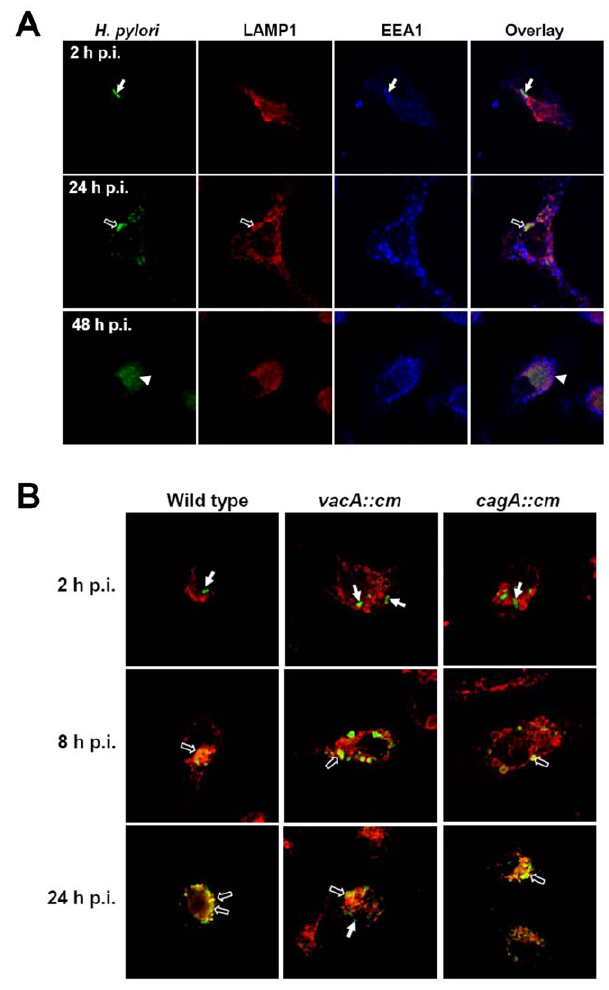
Figure 3. H.pylori in LAMP1 + vesicles within BMDCs. (A) The endocytic trafficking of H. pylori within BMDCs. BMDCs were infected with HP238 at m.o.i.=10. At 2, 24, or 48 h post infection, the infected cells were stained with anti- H. pylori antibodies (green), anti-EEA1 antibody (blue), or anti-LAMP1 antibodies (red). Confocal images show the localization of H. pylori with EEA-1 + or LAMP-1 + vesicles. Closed arrows indicate EEA-1 + H. pylori -containing vesicles, opened arrows indicate LAMP-1 + H. pylori -containing vesicles and triangles indicate the digested bacteria particles. (B) H. pylori can replicate in LAMP1 + vesicles within BMDCs. BMDCs were infected with HP238 wild type, vacA ( vacA::cm ) and cagA ( cagA::cm ) mutant at m.o.i.=10. At 2, 8 and 24 h post infection, the infected cells were stained with anti- H. pylori antibody (green) and anti-LAMP-1 antibodies (red). Confocal images show the localization of H. pylori on LAMP1 + vesicles. The closed arrows indicate the bacteria without LAMP-1 surround and the opened arrows show H. pylori + and LAMP-1 +